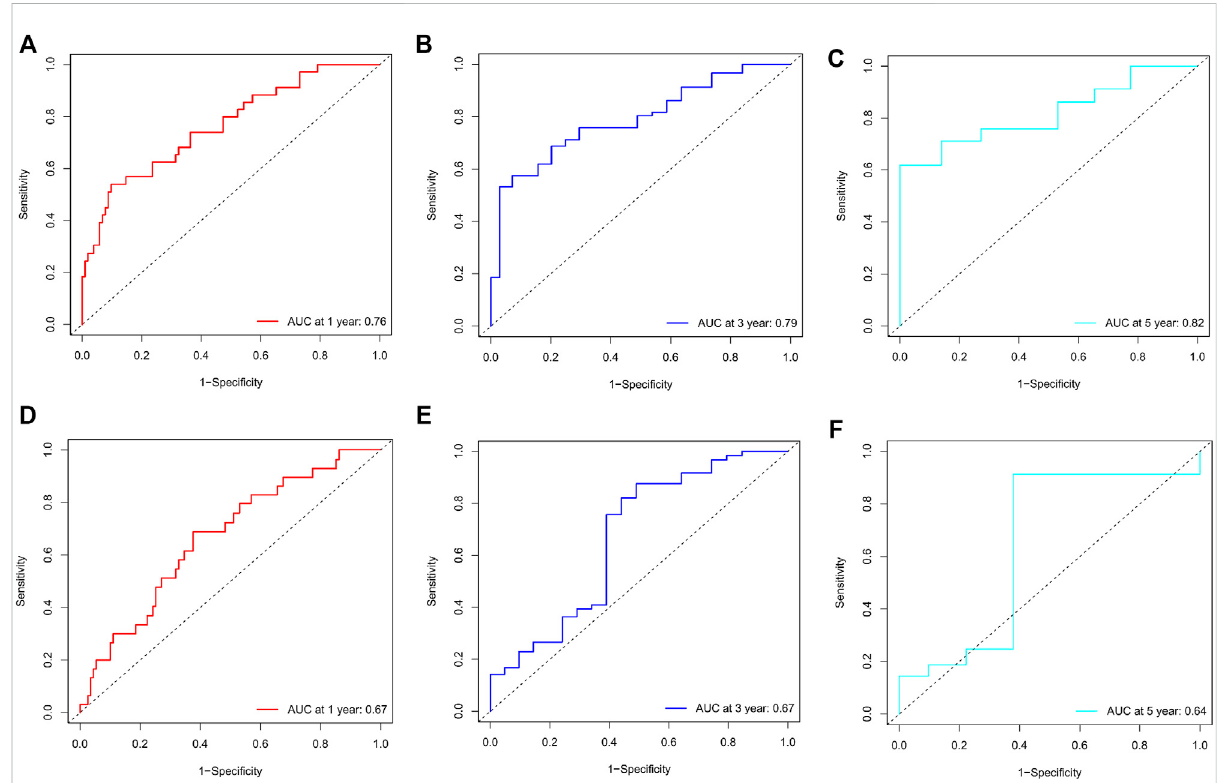
FIGURE 5 (A – C) Nomogram ROC curves to predict 1-, 3-, and 5-year overall survival (OS) in the training cohort. (D – F) Nomogram ROC curves to predict 1-, 3-, and 5-year overall survival (OS) in the validation